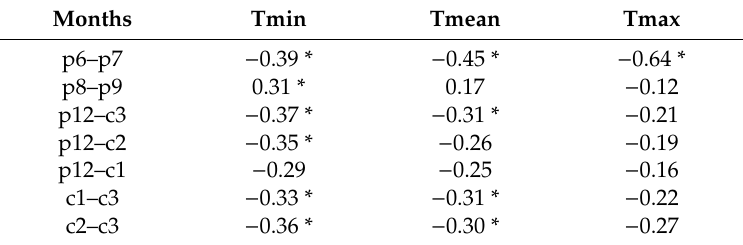
Table 2. Correlations between the ring-width index and meteorological data for di ff erent month